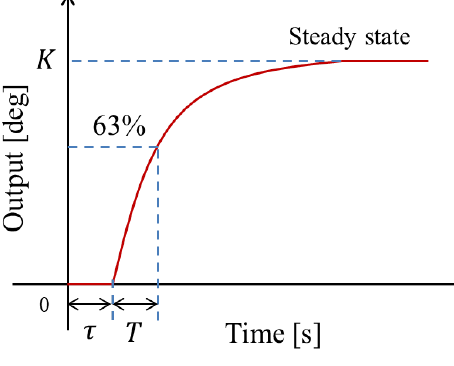
Figure 3. Step response of FOPTD plant.